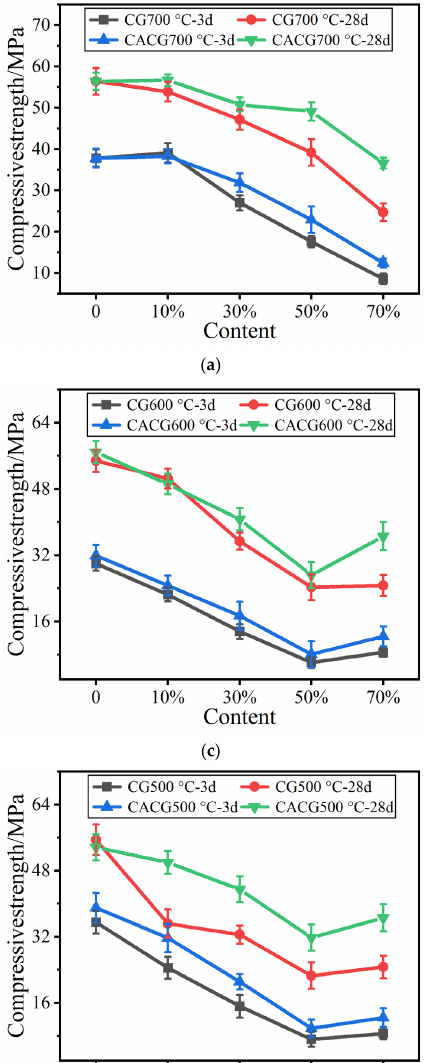
Figure 2. Mechanical strengths of calcium - added calcined gangue. ( a ) Compressive strength. ( b ) Flexural strength.